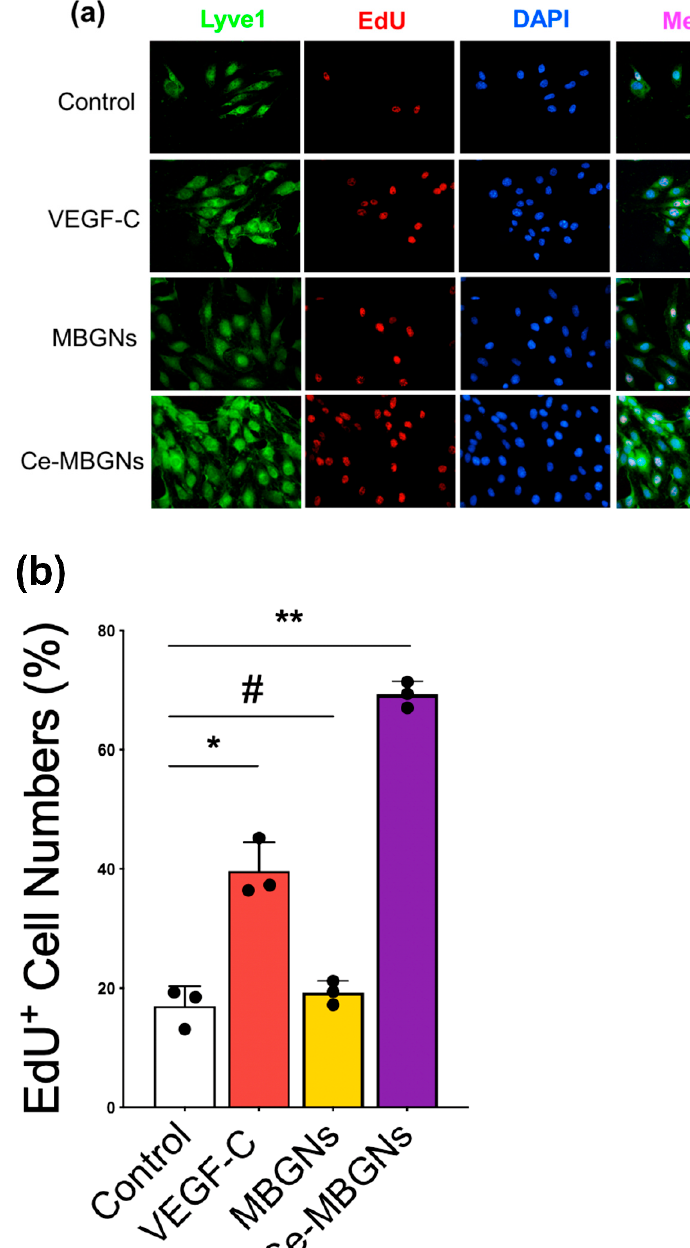
Figure 3. ( a ) Fluorescence images (Lyve1, EdU, DAPI) and ( b ) the quantitative EdU assay result demonstrating that the proliferation of LECs cultured in conditioned media containing Ce-MBGNs (1 wt/v% extract) was remarkedly increased compared to VEGF-C (50 ng/mL), MBGNs (1 wt/v% extract) and the control groups. Nuclei are stained with DAPI (blue). Scale bar = 50 µ m. p < 0.05 (*), p < 0.01 (**) and p > 0.05 (#).